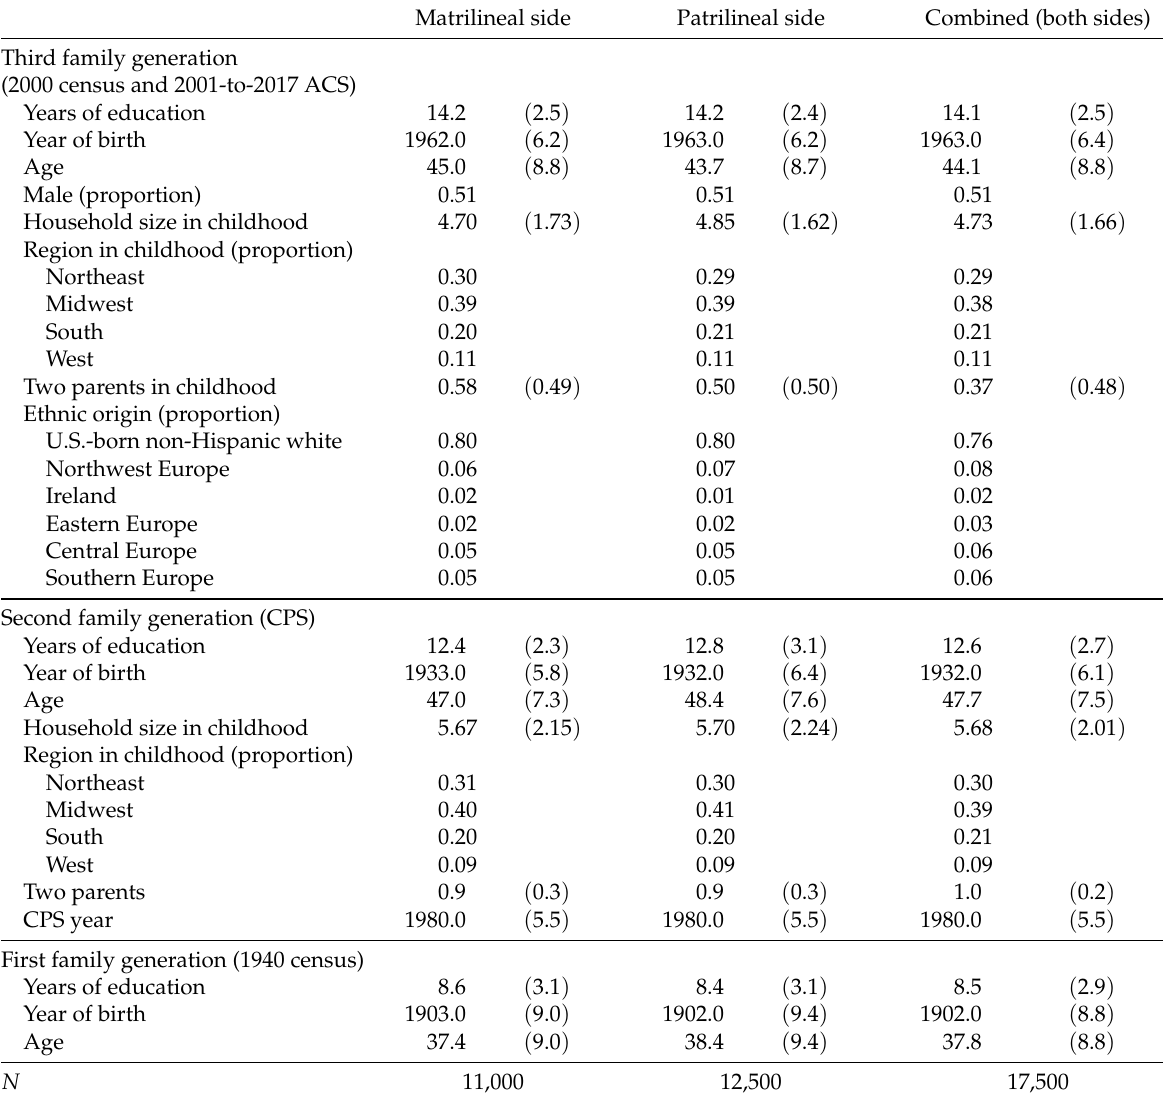
Table 1: Sample descriptives (mean or proportion)